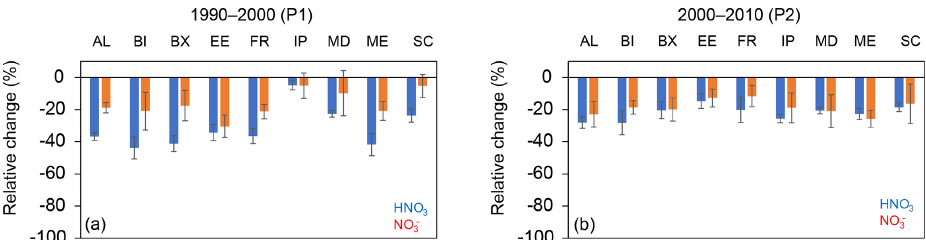
Figure 10. Modeled relative trends in HNO 3 and NO − periods. The columns show the averages (over land) of all the model estimates and the bars show the standard deviation with respect to the